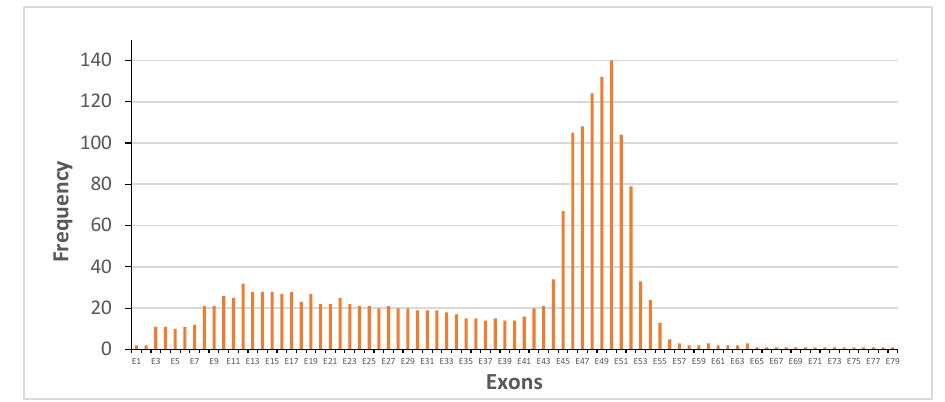
Figure 6. Frequency of single exon deletions in the dystrophin gene, observed in patients with DMD.